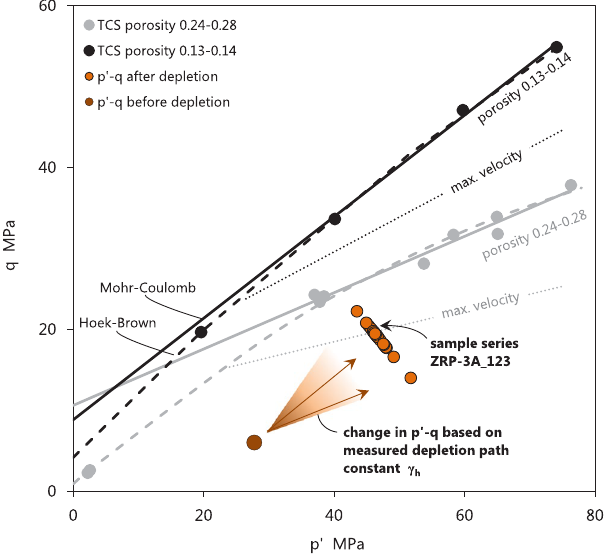
Figure 2. Overview in p ′ -q stress space of the Triaxial Compressive Strength (TCS) and Pore Pressure Depletion (PPD) tests performed using Zeerijp sandstone samples. The TCS tests were performed using samples with an end-member porosity, and are presented in black (low porosity 0.13–0.14) and grey (high porosity 0.24–0.28). Solid points represent the peak stress at failure, for which per sample the Mohr-Coulomb (solid line) and Hoek-Brown (dashed line) criteria have been fit. A fit of the maximum ultrasonic p-wave velocities during axial loading is shown in dotted lines, for both data sets, to indicate the likely location of the critical state line. The dotted line physically indicates the boundary between densification-dominated deformation (below), and cracking-dominated deformation (zone between maximum velocity and failure lines). The PPD tests start at the virgin in-situ stress (dark brown point), and by the responding radial stress change follow a stress path with a fixed depletion path constant γ h = Δ S rad / Δ P p . Final p ′ -q conditions for all PPD tests (light brown points) are hence at higher p ′ -q, but still below the failure line and within the brittle field. No evidence for shear or compactant collapse was observed. However, note that the p ′ -q at post-depletion conditions for sample series ZRP-3A_123 with a porosity of 0.22 are approaching the maximum velocity line, and may hence be close to the critical state line when fully depleted. Refer here to the stress path in Fig. 1, and the acoustic emissions data in Fig. 6, for sample ZRP-3A_123D